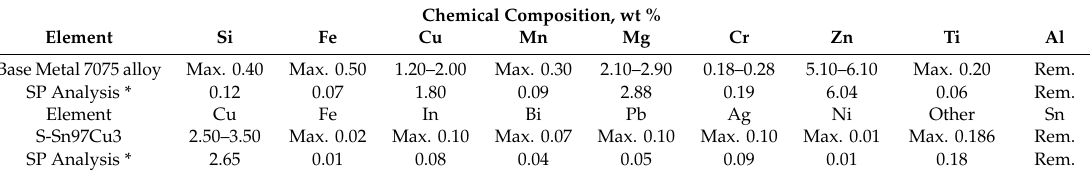
Table 1. Chemical composition of base metal and filler metal.